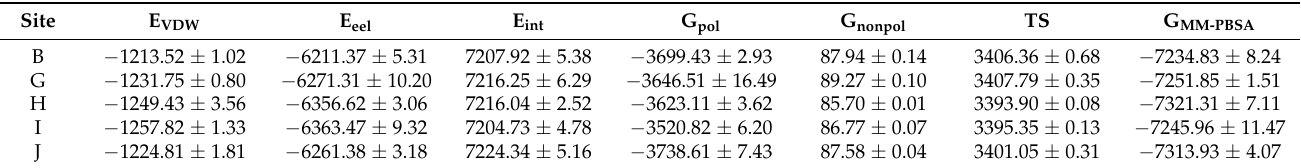
Figure 8. The time course of root–mean–square deviations of mainchain atoms of the transmembrane domains (7TM, black), heavy atoms of C-2 after least-square (LS) fitting (LIG, red) and heavy atoms of C-2 without fitting (LIG, green). To calculate the No-Fit RMSDs for C-2, the mainchain atoms of 7TM were first aligned and the resulting translation–rotation matrix were then applied to the ligand. After the coordinate transformation, the RMSDs were calculated directly. ( A ) site B, ( B ) site G, ( C ) site H, ( D ) site I and ( E ) site J. Table 2. Energy decomposition of MM-PBSA-WSAS free energy for the CB2/CP55940/C-2 complex. All energies are in kcal/mol.